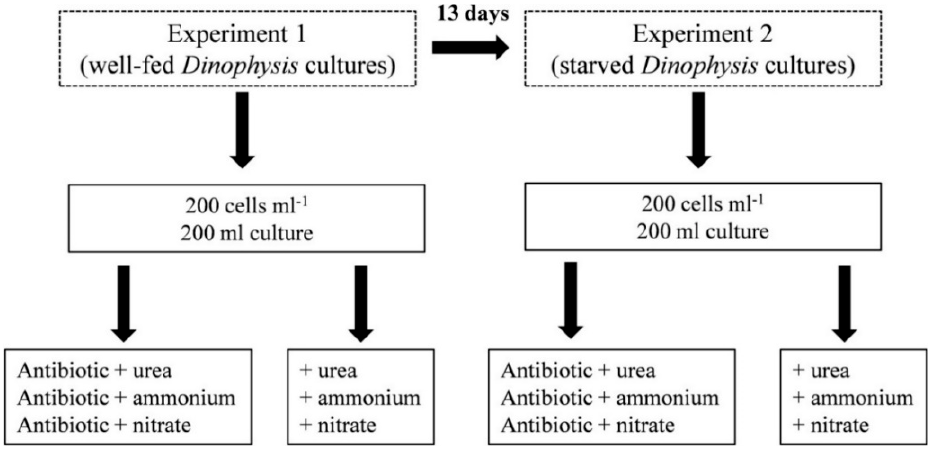
Figure 1. Diagram of the experimental design.